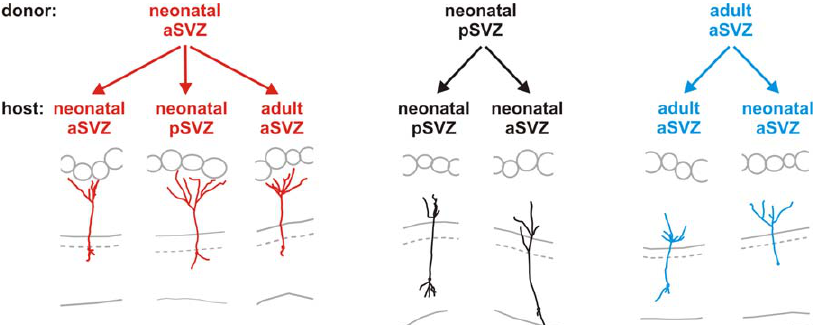
Figure 6. Reconstructions of Transplanted GCs Revealed That They Maintained Their Lamina-Specific Dendritic Targeting after Transplantation GC reconstructions revealed that the new GCs maintained their lamina-specific dendritic targeting after the different transplantation conditions indicated. The bar indicates 100 l